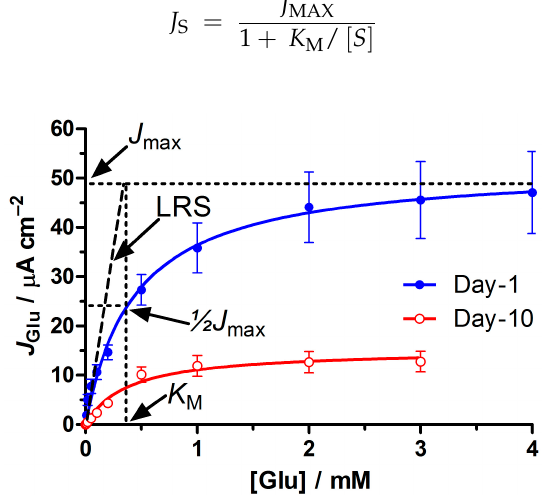
Figure 1. Initial studies using recombinant GluOx in combination with PEI, but without a permselective barrier or crosslinking agent. Calibration data and non-linear regression (Equation